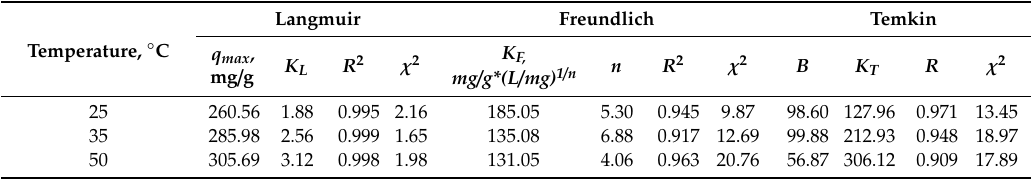
Table 2. Isotherm predicted values for the adsorptive removal of As(V) on La 2 O 3 (0.1 g / L) nanorods at pH 6.0 and 25 ◦ C for 60 min